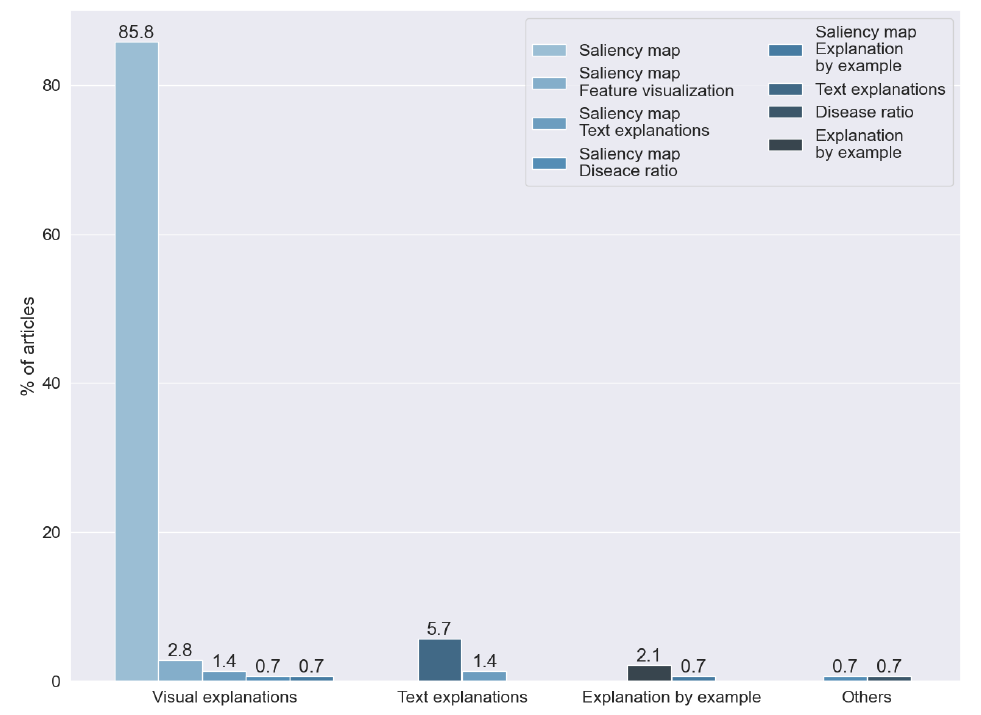
Figure 16. Kind of explainability found by answering RQ7. Vertical axis indicates the percentage of articles for each